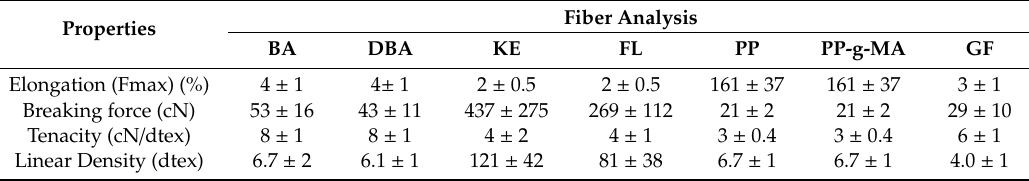
Table 1. Mechanical analysis of various fibers by Favigraph